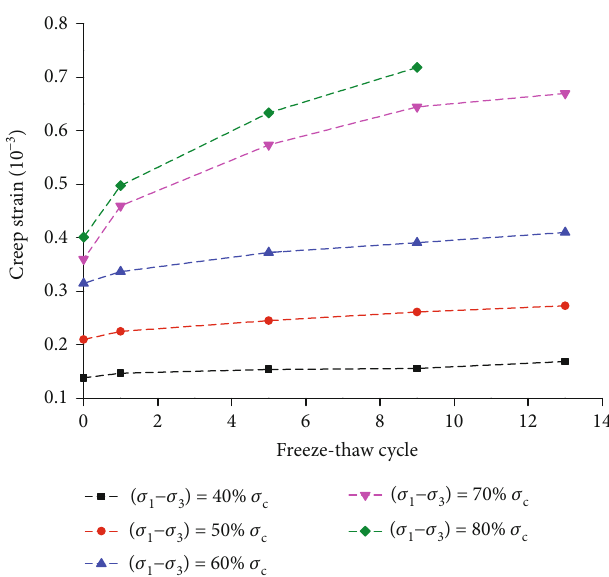
Figure 13: Curves of the creep strain versus the number of freeze-thaw cycles at various stress levels under 2MPa of con fi ning pressure.